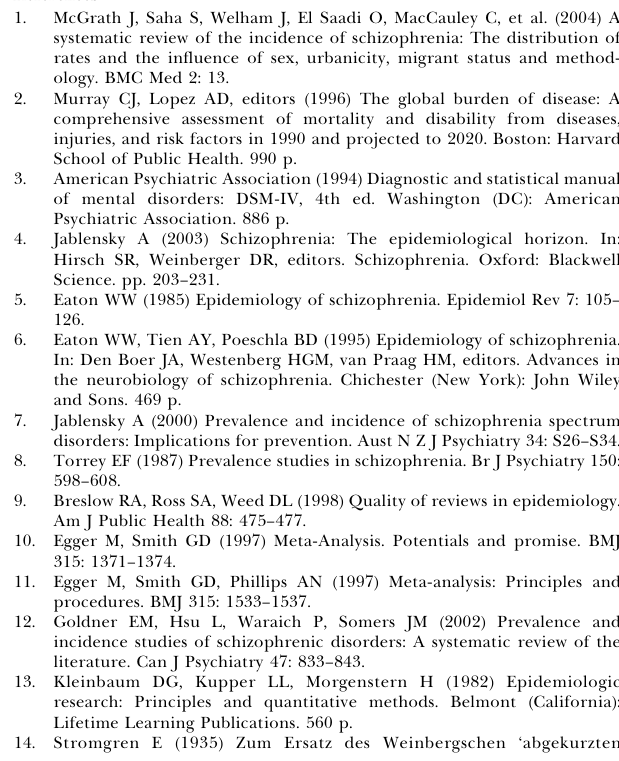
Table S1. Definitions of Prevalence Estimate Types Table S2. Definitions for the Variables Used to Characterize the Prevalence Studies Found at DOI: 10.1371/journal.pmed.0020141.st002 (43 KB DOC). Table S3. Quality Score Criteria Found at DOI: 10.1371/journal.pmed.0020141.st003 (38 KB DOC). Table S4. Characteristics of Core Prevalence Studies Found at DOI: 10.1371/journal.pmed.0020141.st004 (644 KB DOC). Table S5. Characteristics of Migrant Prevalence Studies Found at DOI: 10.1371/journal.pmed.0020141.st005 (136 KB DOC). Tables S6. Characteristics of Other Special Groups Prevalence Studies Found at DOI: 10.1371/journal.pmed.0020141.st006 (243 KB